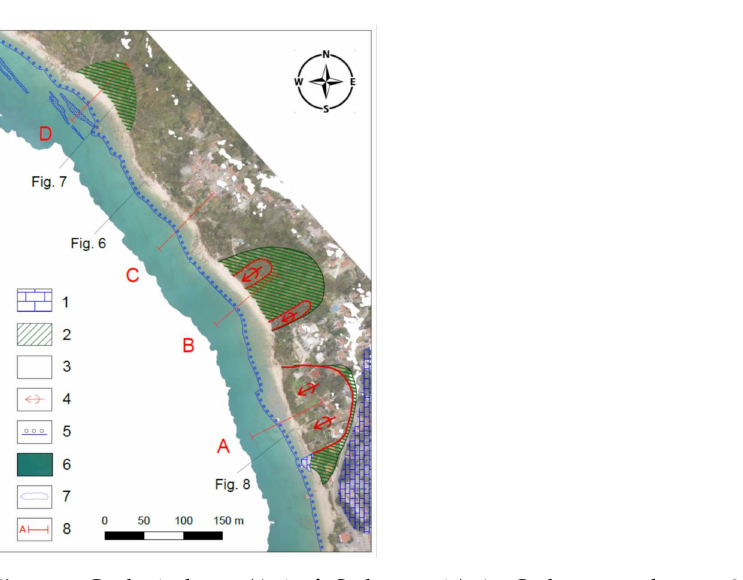
Figure 4. Geological map (Agisoft Orthomosaic): 1—Carbonate rock mass, 2—Flysch rocks overlain by colluvium, 3—Talus breccia, 4—Landslide, 5—Boundary of beach bodies, 6—Sandy